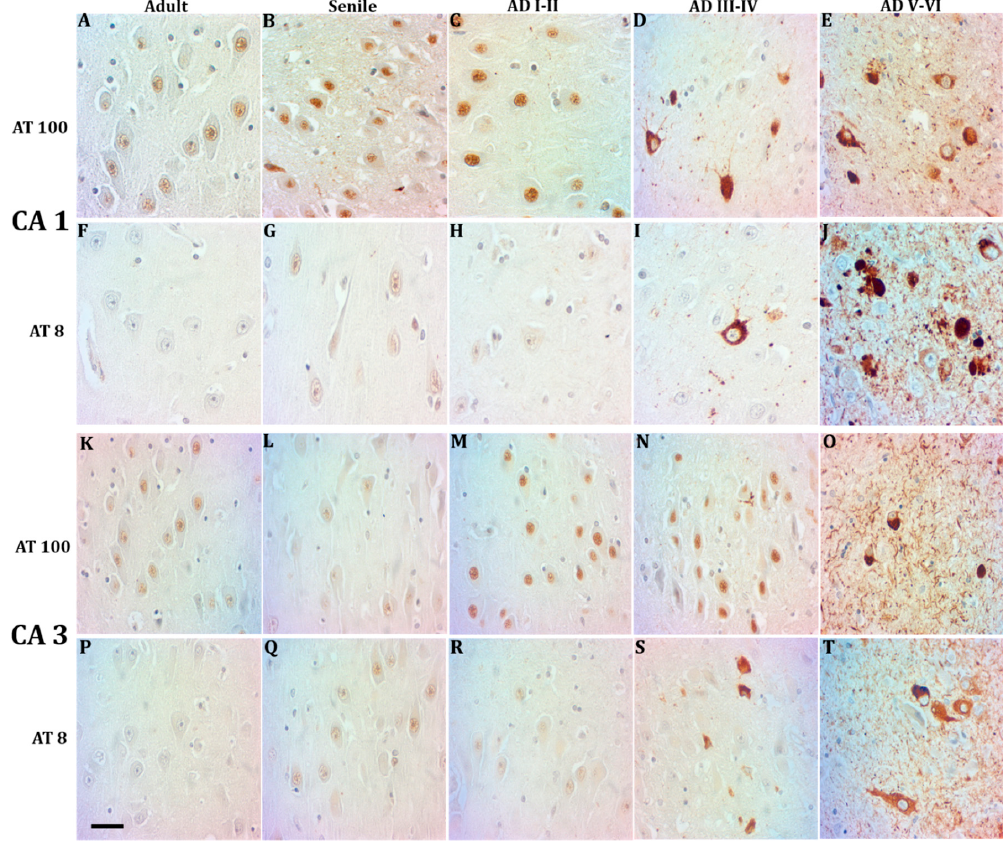
Figure 1. Neurons containing phosphorylated Tau in the CA1 and CA3 hippocampal regions in mature, elderly, and AD I-VI stages of Braak. Immunopositive AT100 nuclei in mature and senile neurons ( A , B , K , L ). AD I-II nuclei present both intense and fading immunostaining ( C , M ), while in middle AD stages it shows cytoplasmic and only some slightly positive nuclei ( D , N ). Exclusive localization in the cytoplasm in late AD ( E , O ). AT8 is present in nuclei of senile and early AD ( G , H , Q , R ) but not in mature stages ( F , P ). Tangles and immunopositive neuropile in the middle and late AD stages ( I , J , S , T ). scale bar10 µm.